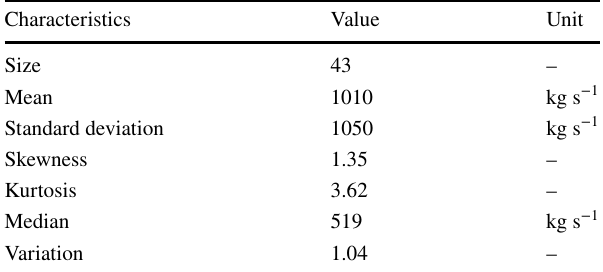
Table 3 The empirical characteristics of the solid flow series